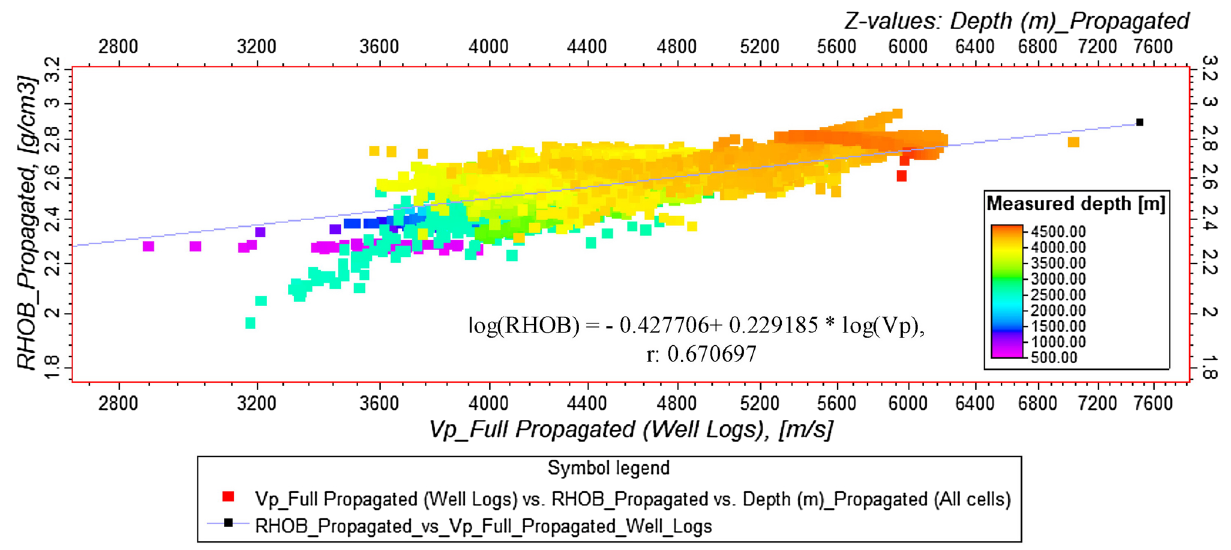
Fig. 5 Logarithmic relation of density cube graphs to compression velocity of South Azadegan